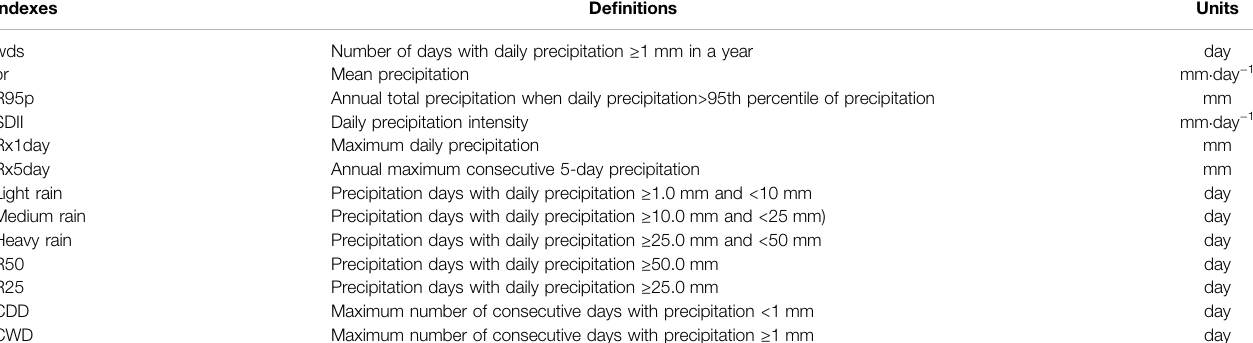
TABLE 1 | De fi nitions of extreme precipitation indexes.